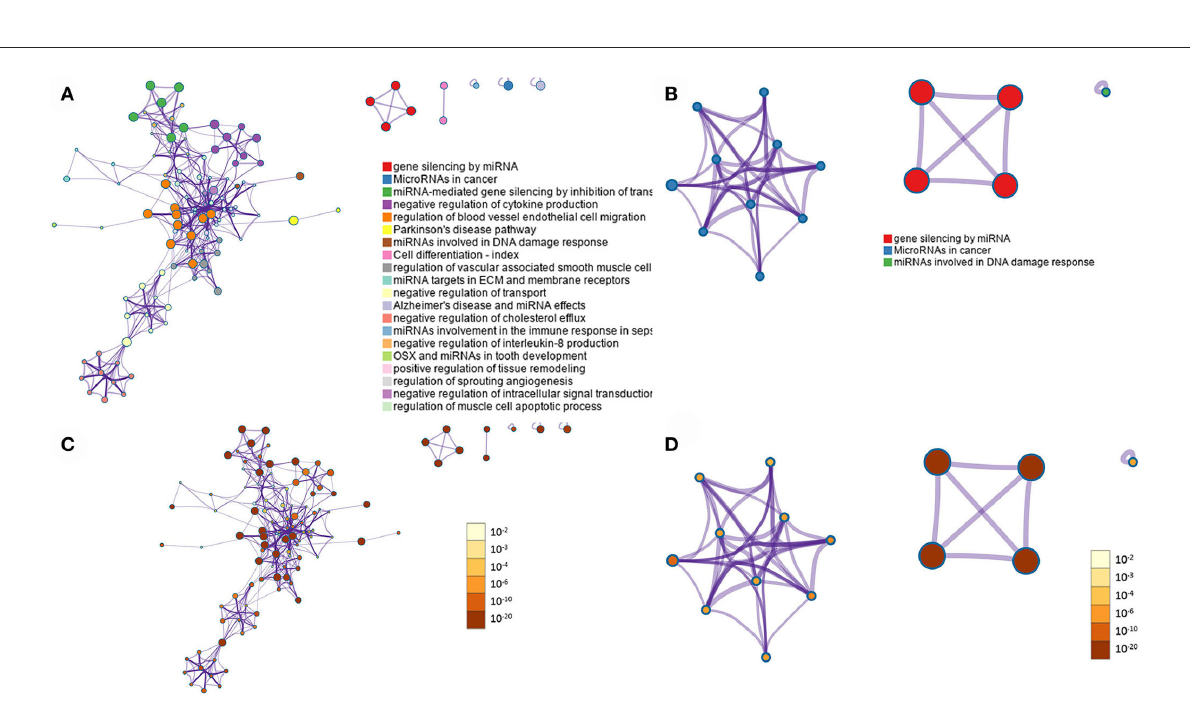
FIGURE5 Summary of enrichment analysis. Network analysis of the GO terms with the different colored nodes representing the terms within the pathways. (A) All miRNAs expressed. (B) Differentially expressed miRNAs. Nodes are also evaluated by p-value, with the darker colors representing lower p-values, indicating higher significance of the node. (C) All miRNAs expressed. (D) Differentially expressed miRNAs. Images prepared by